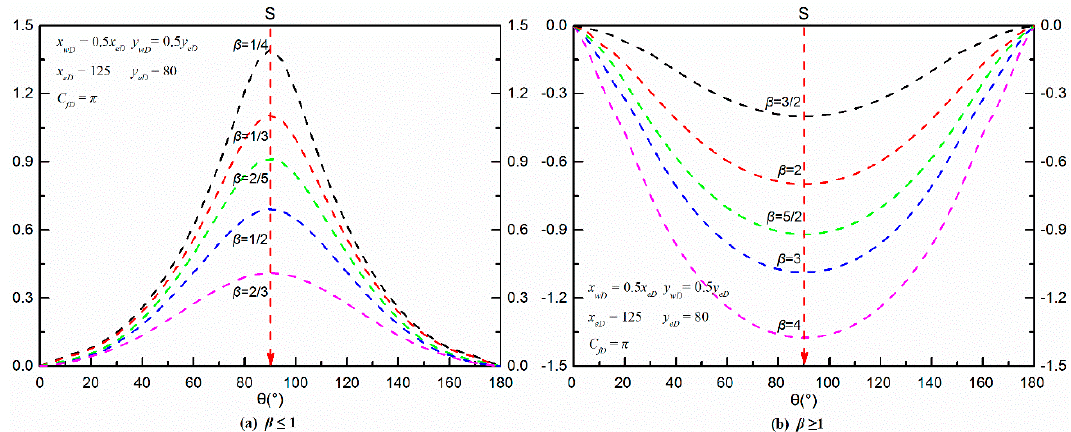
β ≤ β ≥ ; ( b ) 1 . Figure 6. E ff ect of permeability anisotropy on pseudo-skin factor: ( a ) β ≤ 1; ( b ) β ≥